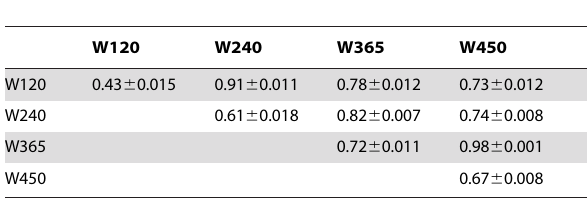
Table 3. Estimates of the mean and standard-deviation of direct heritability (diagonal) and genetic correlation (above diagonal) for weight at 120, 240, 365 and 450 days